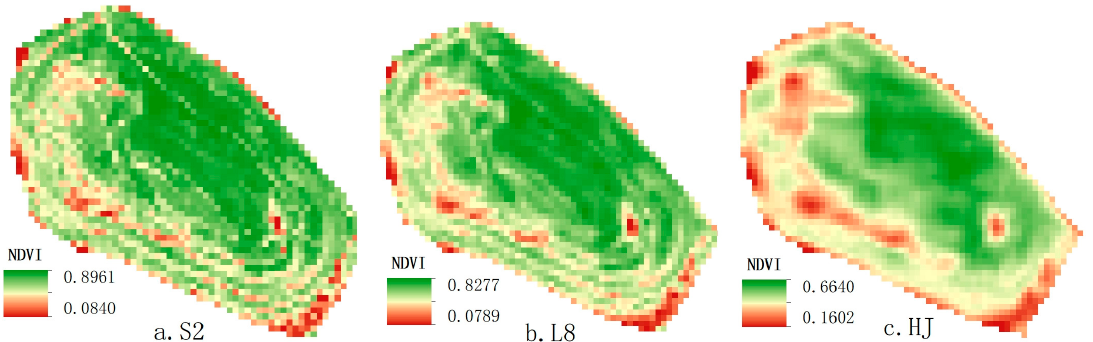
Figure 3. NDVI monitored by different satellite sensors in the South Dump (( a ): NDVI caculated from Sentinel-2(S2); ( b ): NDVI caculated from Landsat 8(L8); ( c ) NDVI caculated from HJ).